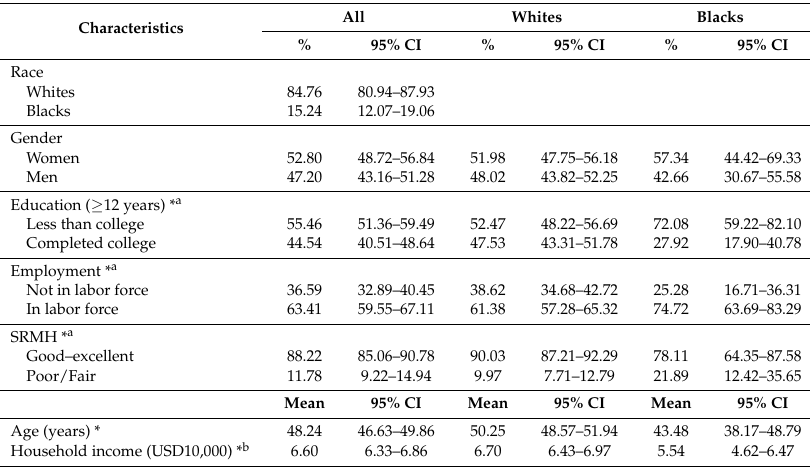
Table 1. Descriptive statistics in the pooled sample and by